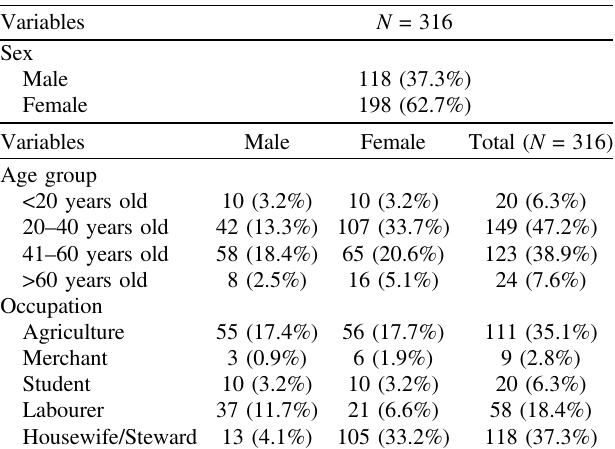
Table 4. Demographic data of villagers participating in the questionnaire survey in the three villages